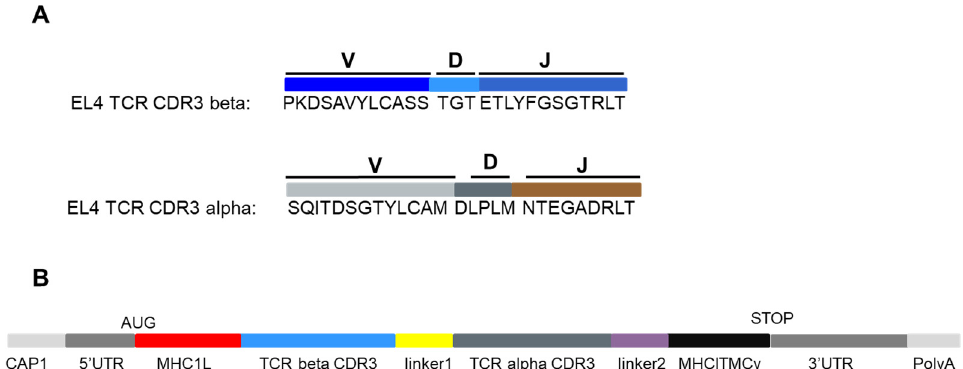
Figure 1. Design of the mRNA vaccine. The V(D)J sequence of the mouse EL4 TCR alpha and beta chains is given in ( A ). In ( B ), the structure of the ivt mRNA is provided. UTR: untranslated region,